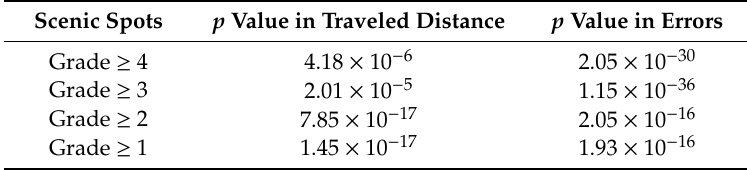
Table 4. The statistical significance test after t